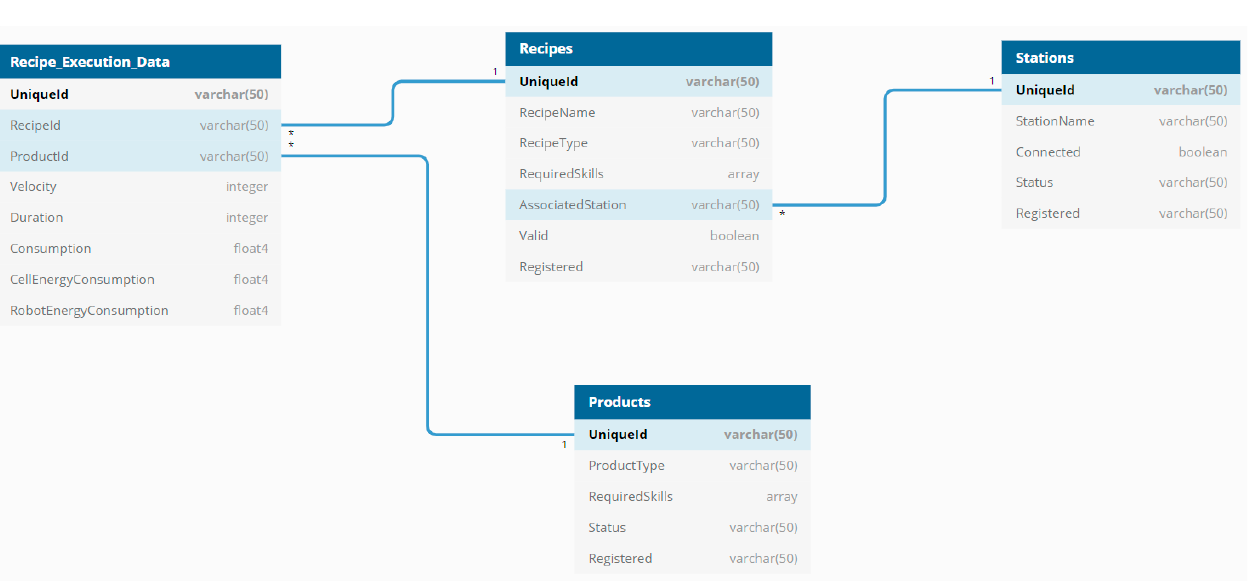
Figure 8. Data Model.